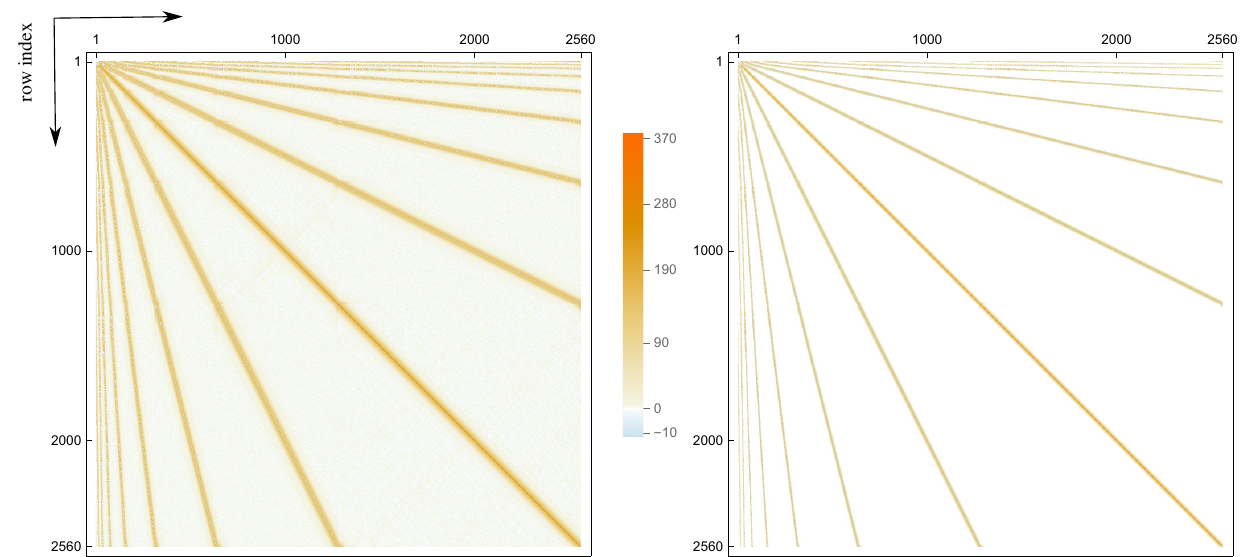
FIG. 1. Visual representation of the exact (left) and approximate ICM (right) for the ground state of the discretized free QFT in a multiscale wavelet basis. The column (row) index of the visualized matrix is ordered from left (top) to right (bottom), just as the typical format of a matrix. The values of matrix elements are represented by different colors with the shown color scale. The number of modes for the discretized QFT is N = 2560, free mass is m 0 = 1, and the Daubechies wavelet with index K = 3 is used. The exact ICM is a quasisparse matrix, meaning most of its elements are nearly zero. Elements of the exact matrix with a magnitude less than 10 − 8 are replaced with zero to obtain the approximate ICM. The approximate ICM has a specific sparsity structure known as the “fingerlike” sparsity